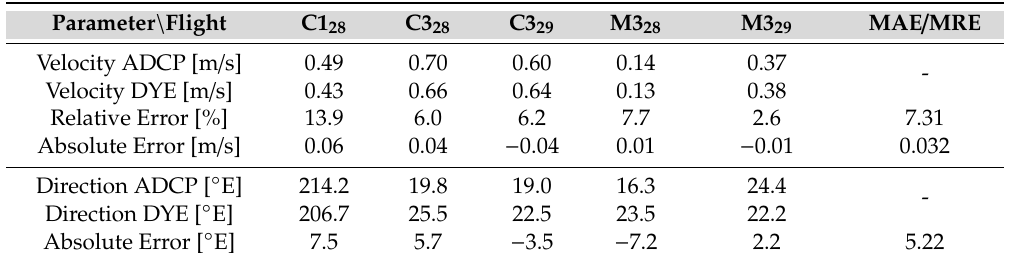
Table 7. Surface water flow velocity and direction measured using an ADCP and calculated using dye clouds detected by our image processing algorithm. For the velocity, the relative and absolute errors are reported. For the direction, only the absolute error is reported. The direction was measured in degrees from the east (counterclockwise).